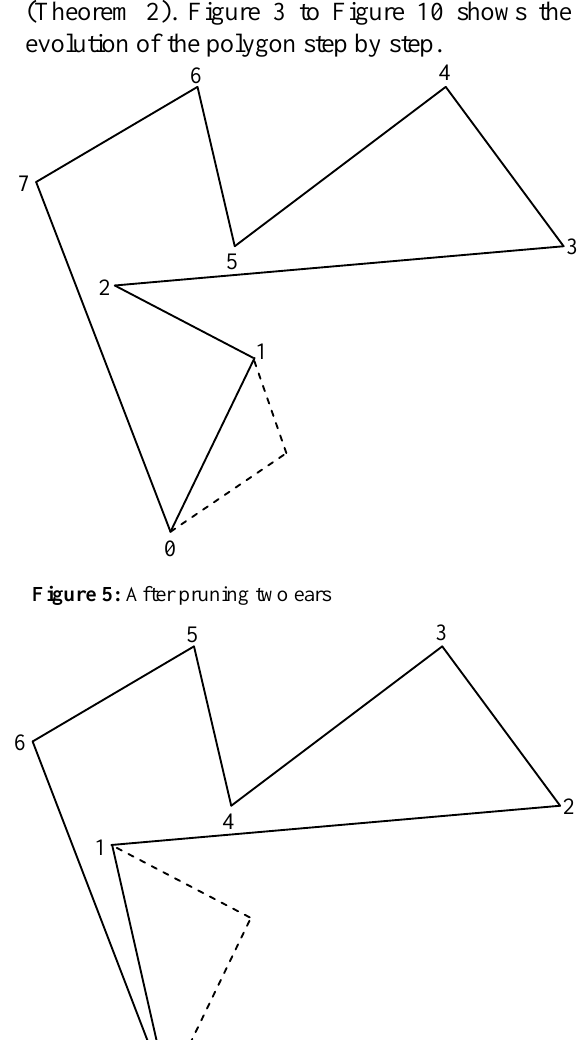
Figure 6: After pruning three ears